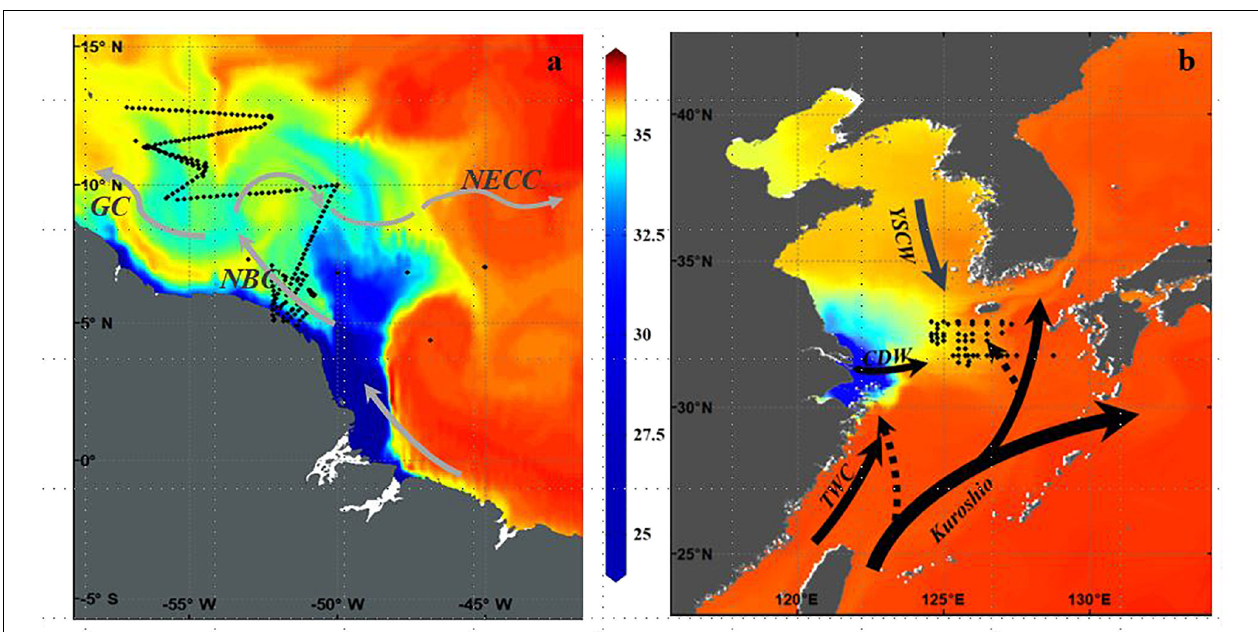
FIGURE 1 | (a) Cruise track of R/V Knorr cruise KN197-8 in May-June 2010 showing CTD stations occupied and underway sampling track overlaid on a map of model (1/6 ◦ HYCOM) derived salinity distribution. Currents according to Coles et al. (2013) are North Brazil Current (NBC), Guyana Current (GC), and North Equatorial Counter Current (NECC) (b) Sampling locations during four cruises in July (2009 to 2011 and 2013) in the mid-shelf East China Sea overlaid on a map of model (Japan Coastal Ocean Prediction Experiment) derived surface salinity distribution. Solid lines indicate the Kuroshio Current, the Changjiang Diluted Water (CDW), the Taiwan Warm Current (TWC), and Yellow Sea Coastal Water (YSCW). Dashed lines indicate two Kuroshio intrusions one into the northeast of Taiwan and the other into the southwest of Kyushu.